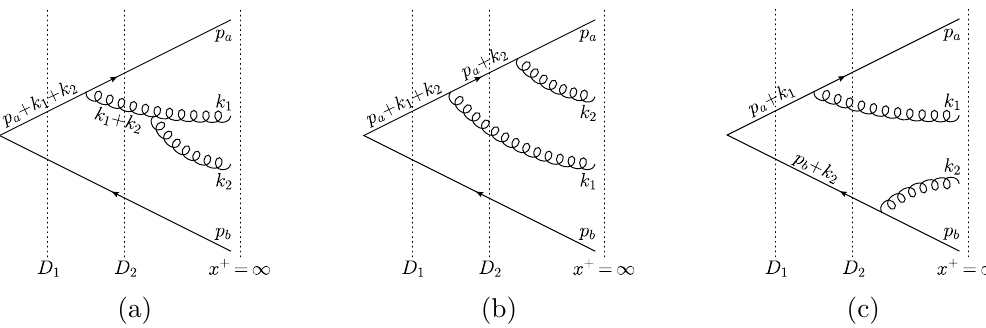
Figure 4 . Three over the six topologies contributing to the 2-gluon amplitude in LCPT. As discussed in the text, we consider only diagrams in which the harder gluon is emitted prior to the softer one ( k + (cid:29) k + ). Also, albeit this is not visible in the graphical representation, we consider 1 2 emission angles which are much larger than the antenna opening and strongly increasing from the (cid:12)rst emission to the second one ( (cid:18) 2 (cid:29) (cid:18) 1 (cid:29) (cid:18) ab